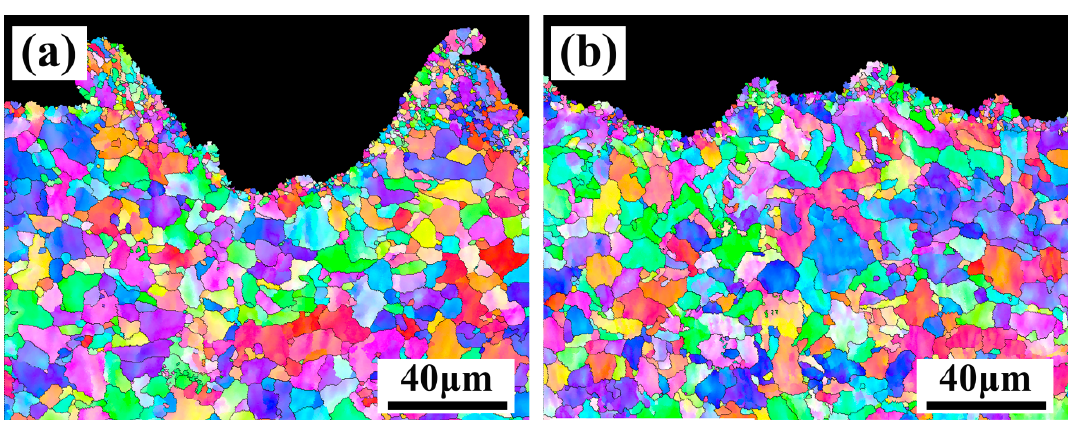
Figure 14. SEM image of the microstructure of the cross-section of the cleaned Q345 steel at a Y-moving speed of 7 mm/s and different X-scanning speeds after laser cleaning. ( a ) microstructure at 500 mm/s; ( b ) enlarged microstructure of the peak at 500 mm/s; ( c ) enlarged microstructure of the valley at 500 mm/s. ( d ) microstructure at 1000 mm/s; ( e ) enlarged microstructure of the peak at 1000 mm/s; ( f ) enlarged microstructure of the valley at 1000 mm/s.